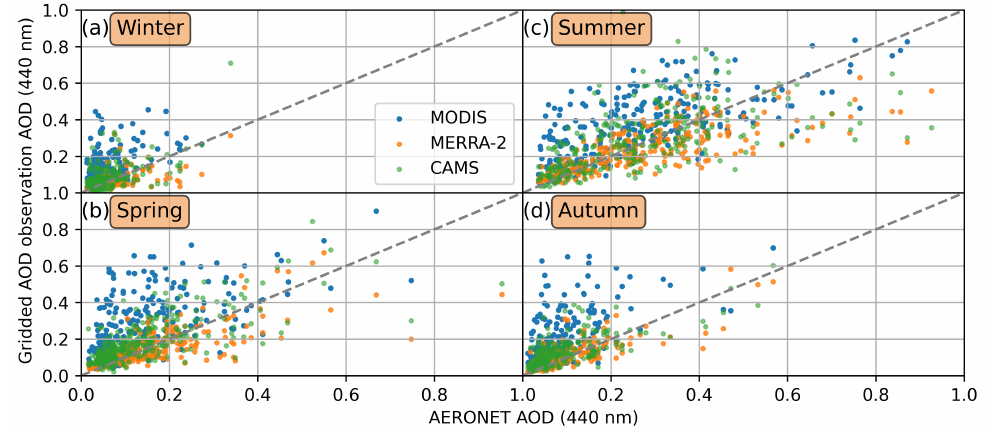
Figure 7. Comparisons of AOD 440 between AERONET and MODIS (blue dots), MERRA-2 (orange dots) or CAMS (green dots) over Ouarzazate for ( a ) winter, ( b ) spring, ( c ) summer and ( d ) autumn. The 1:1 line is represented by the dashed